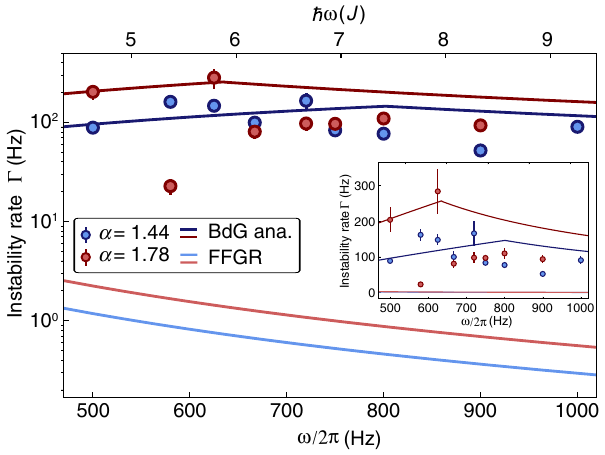
FIG. 10. Instability rates extracted from linear fits to the logarithmic peak amplitudes as a function of modulation time for α ¼ 1 . 44 and α ¼ 1 . 78 . The dark solid lines are the theoretical rates calculated from Eqs. (A5) and (A6) for g ¼ 11 . 5 J , and the bright solid lines are a FFGR calculation for the same modulation parameters according to Eq. (C1). The inset shows the same data on a linear scale to reveal the frequency dependence of the measured rates. Error bars indicate the standard